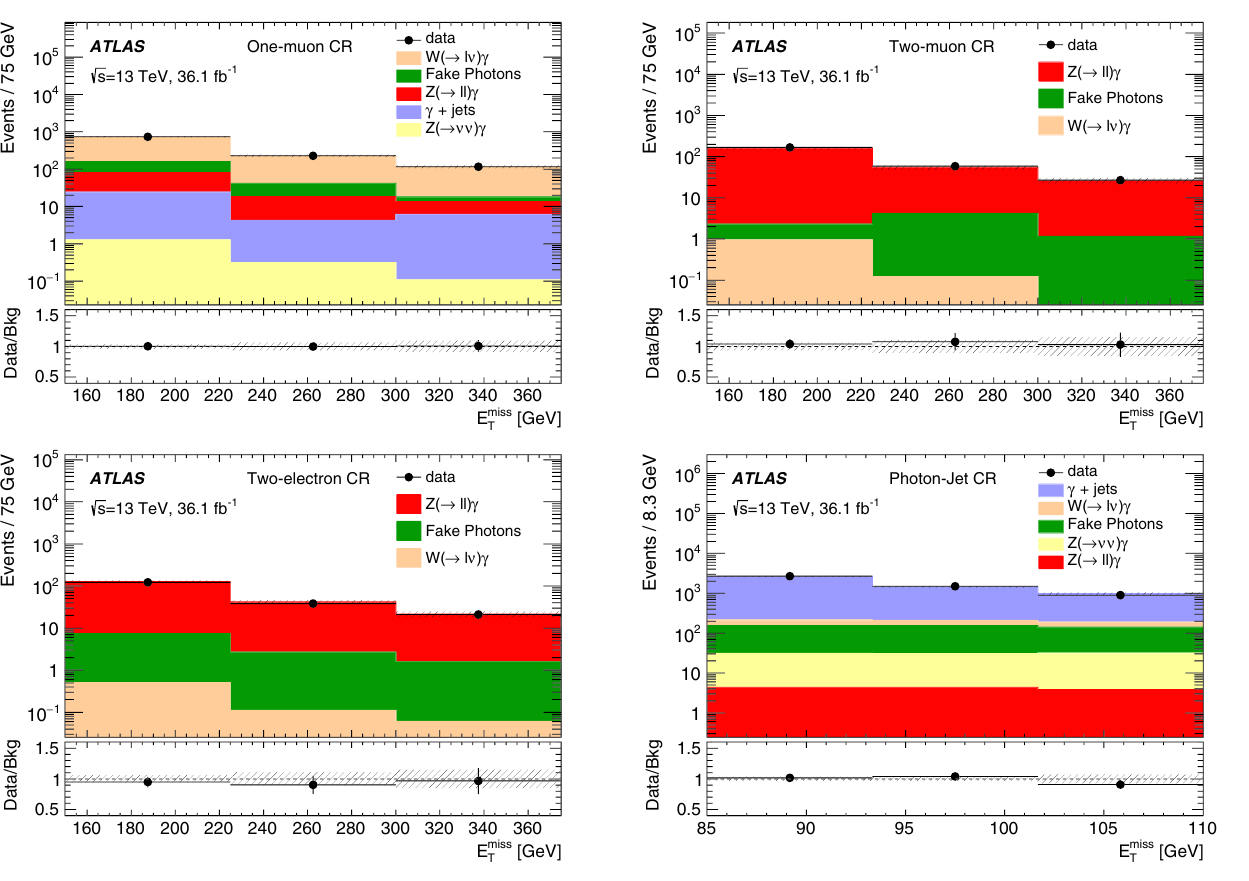
are post-fit uncertainties. The latter are constrained by the fit as the use of control regions to normalise the dominant backgrounds allows to partially cancel some systematic uncertainties (see Sect. 8 for more details). The individual uncertainties can be correlated and do not nec- essarilyaddinquadraturetoequalthetotalbackgrounduncertainty.The total fitted background does not match exactly the sum of the individual